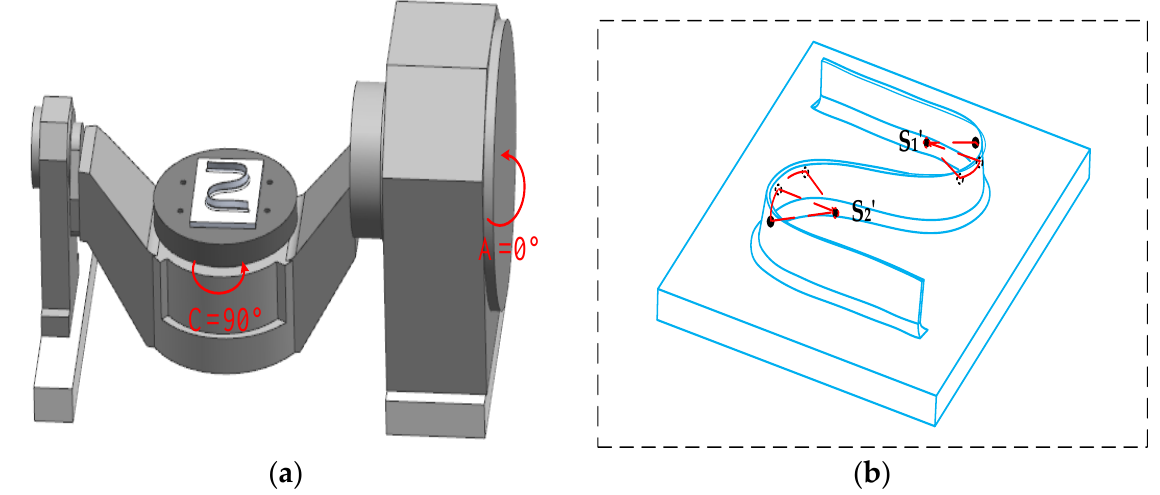
Figure 5. ( a ) Schematic diagram of turntable position when C = 90°, and ( b ) location marking diagram of s-shaped specimen sampling point when C = 90°.